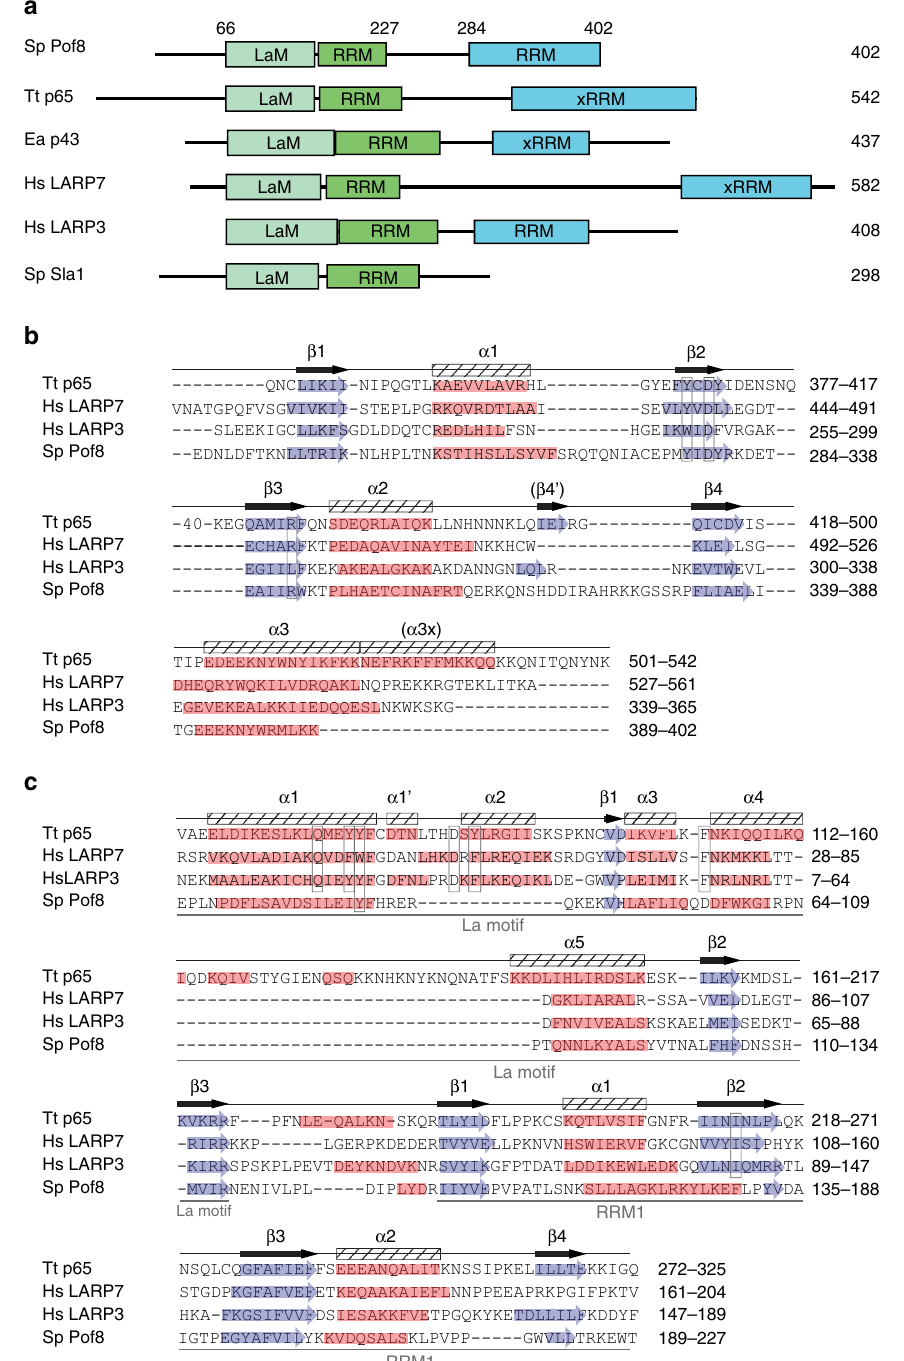
STGDPKGFAFVEFETKEQAAKAIEFLNNPPEEAPRKPGIFPKTV 161–204Hs LARP7 HKA-FKGSIFVVFDSIESAKKFVETPGQKYKETDLLILFKDDYF Hs LARP3 IGTPEGYAFVILYKKVDQSALSKLPVPP-----GWVLLTRKEWT Fig. 1 Pof8 structural analysis reveals a La motif and two RRM domains. a The domain architecture of S. pombe (Sp) Pof8 compared to T. thermophila (Tt) telomerase subunit p65, E. aediculatus (Ea) telomerase subunit p43, Homo sapiens (Hs) LARP7 and LARP3, and the S. pombe La protein, Sla1. Numbers above the Pof8 sequence indicate predicted domain boundaries. b Alignment and secondary structure elements of the C-terminal RRM domains based on HHPred predictions; beta strands are highlighted with blue arrows, and alpha helices are highlighted in red. The secondary structure elements for p65 are based on the crystal structure 27 and are labeled above the alignment. Forty amino acids that form an extended loop between β 2 and β 3 in p65 have been abbreviated -40- to keep the alignment compact. c N-terminal La motif and RRM1 domains. Residues shown to interact with oligo-uridine RNA are boxed and are mostly not conserved in Pof8. The p65 secondary structure elements are labeled above the alignment